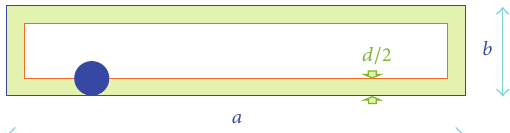
Figure 3: Geometry of the effective sampling area for a certain raindrop size 𝑑 , based on the nominal sampling area.